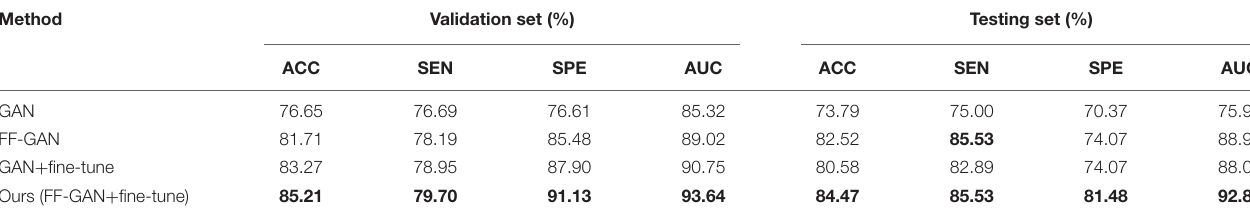
TABLE 5 | Classification performance in complete data experiments by fivefold cross validation.